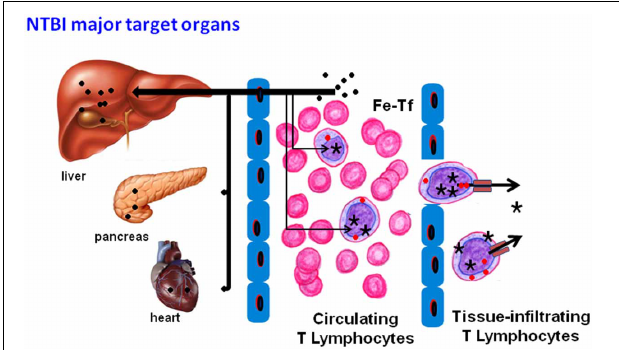
FIGURE 6 | Proposed model of NTBI storage and further utilization for cell growth. When in contact with hepatocytes, NTBI ( ) is rapidly taken up and stored, this being classically accepted as the most effective mechanism of NTBI clearance from the blood. NTBI in the blood stream is taken up by T lymphocytes, where it integrates the intracellular labile iron pool ( ) and the ferritin stores ( ). These cells, and possibly others, constitute the “circulating” iron storage compartment. When the circulating and liver NTBI clearance capacities are exceeded, other cell types, such as pancreatic beta cells or cardiomyocytes, also take up NTBI, with iron accumulation in the respective organs (pancreas, heart). Besides constituting a first line “safe” deposit of iron, T lymphocytes (and possibly other circulating cells) could also contribute to iron distribution and delivery to other cells and tissues, either in normal physiological (homeostatic erythroid/lymphoid proliferation) or pathological conditions (stress erythropoiesis, inflammation, tumor growth). T lymphocyte-derived iron uptake by target cells could occur as transferrin-bound iron (Fe-Tf) or as NTBI, which could be exported directly via ferroportin or, eventually, by ferritin secretion, as proposed earlier (Dörner et al.,